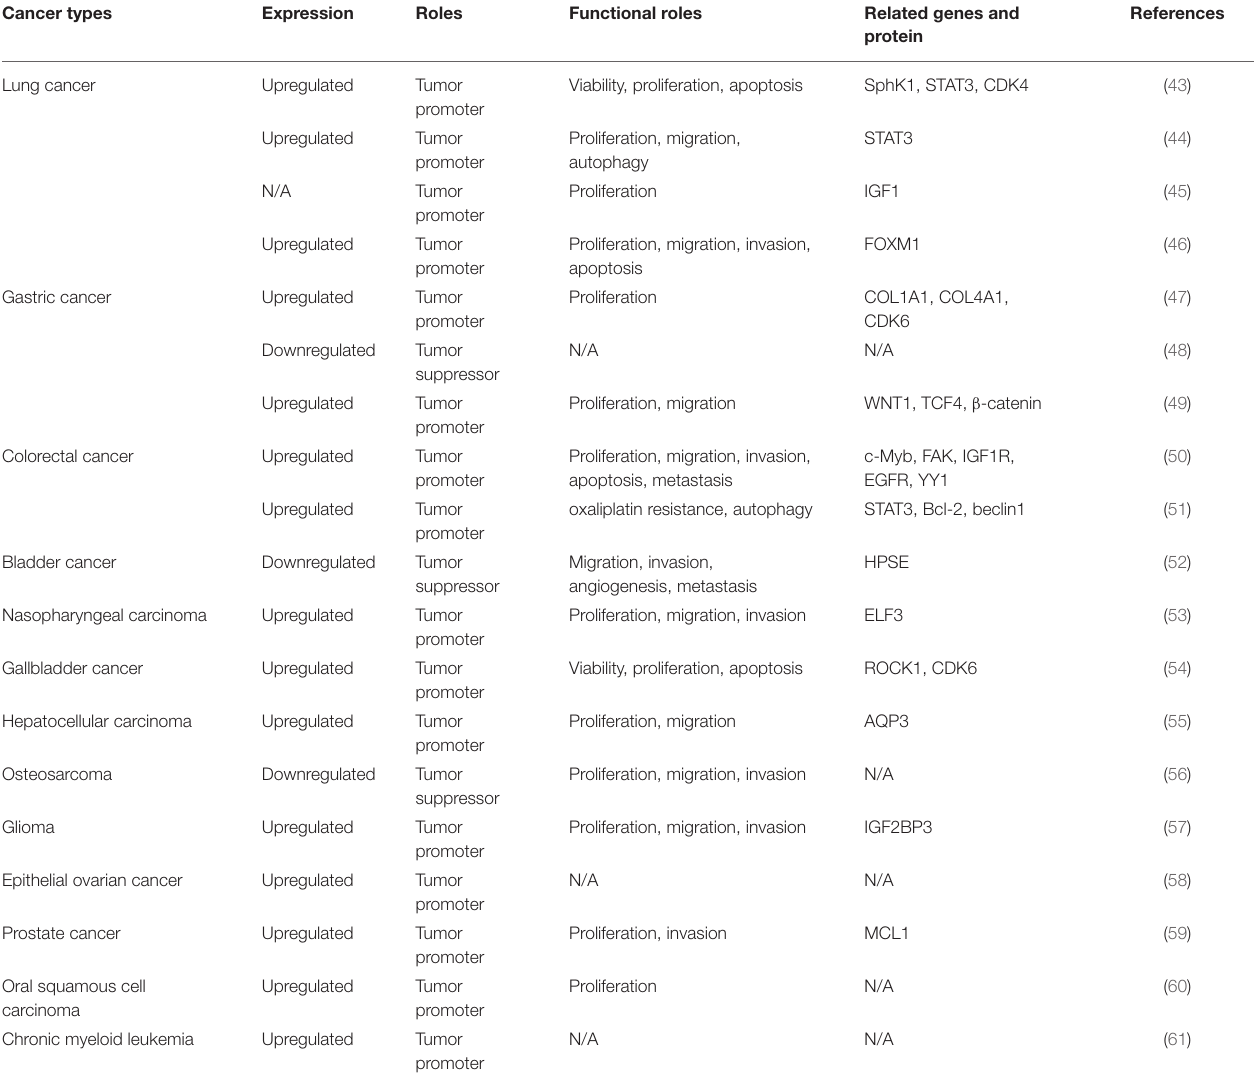
TABLE 1 | Functional characteristics of circHIPK3 in multiple human